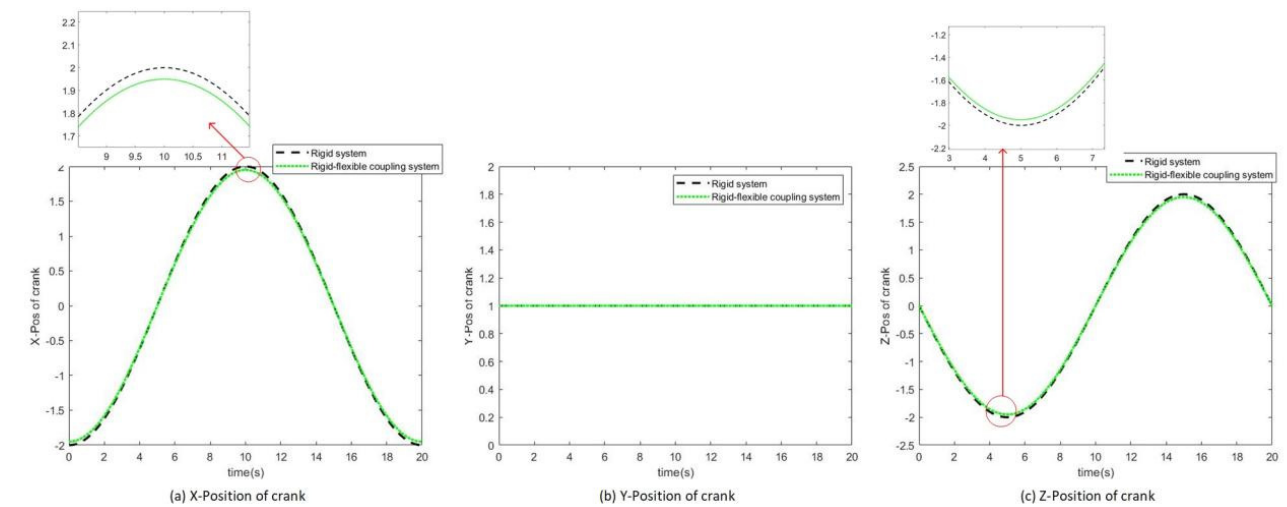
Figure 4. Displacement of crank-connecting rod joint.